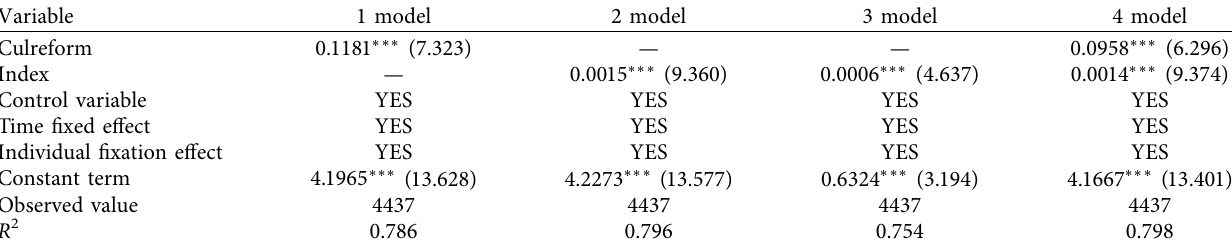
Table 7: Analysis of influence